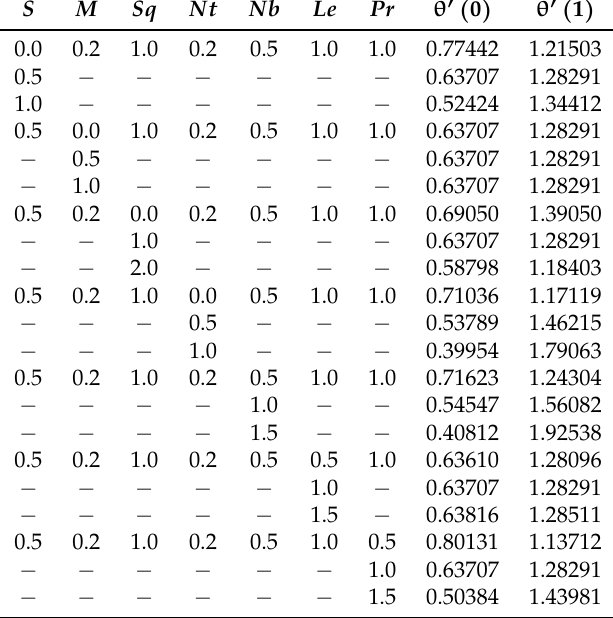
Table 5. Numerical data for local Nusselt number at the lower and upper disks for several values of S , M , Sq , Nt , Nb , Le and Pr